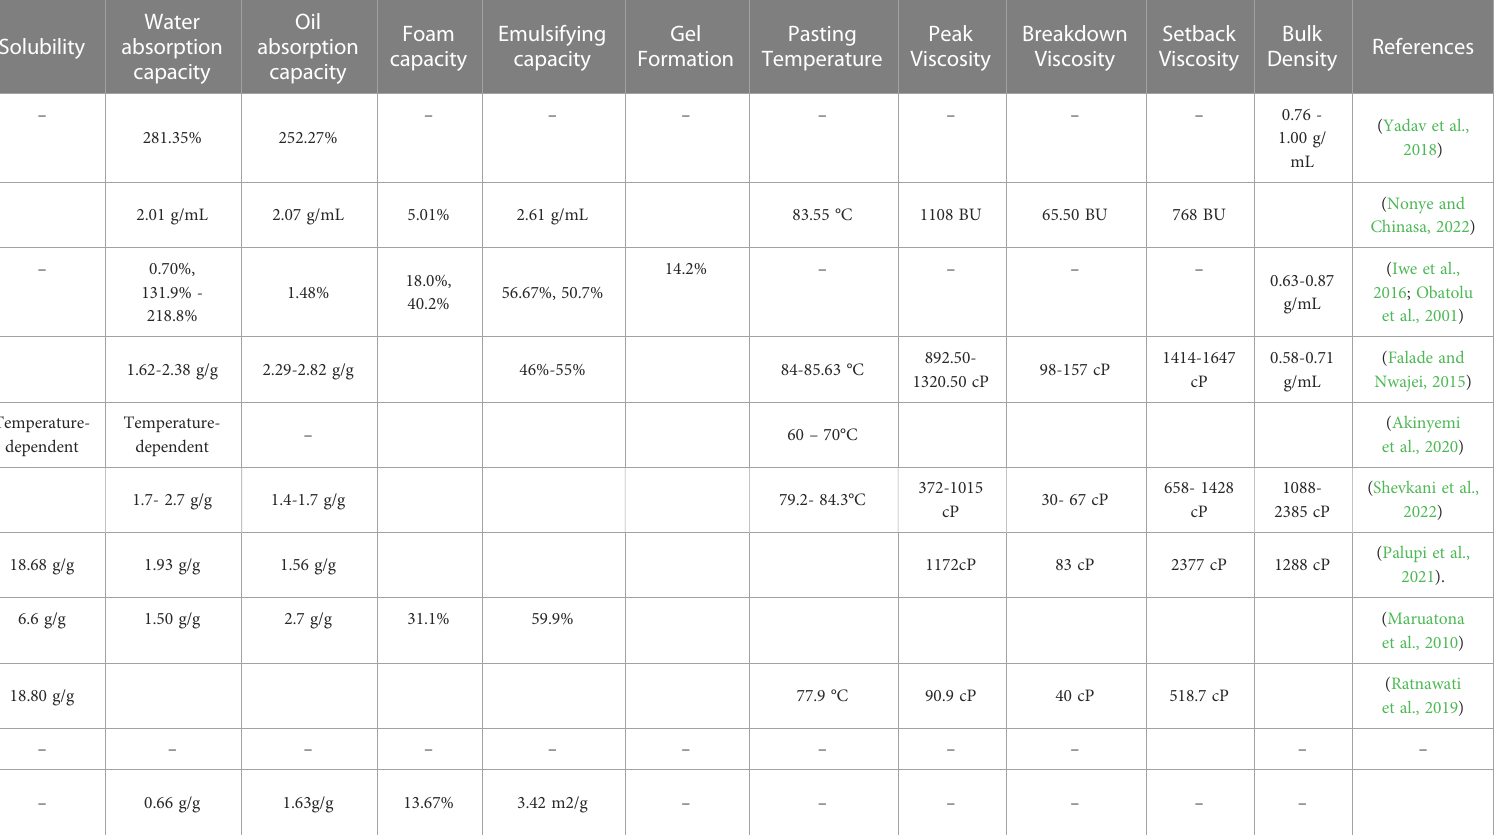
TABLE 3 Functional properties of the selected underutilized legumes considered in this